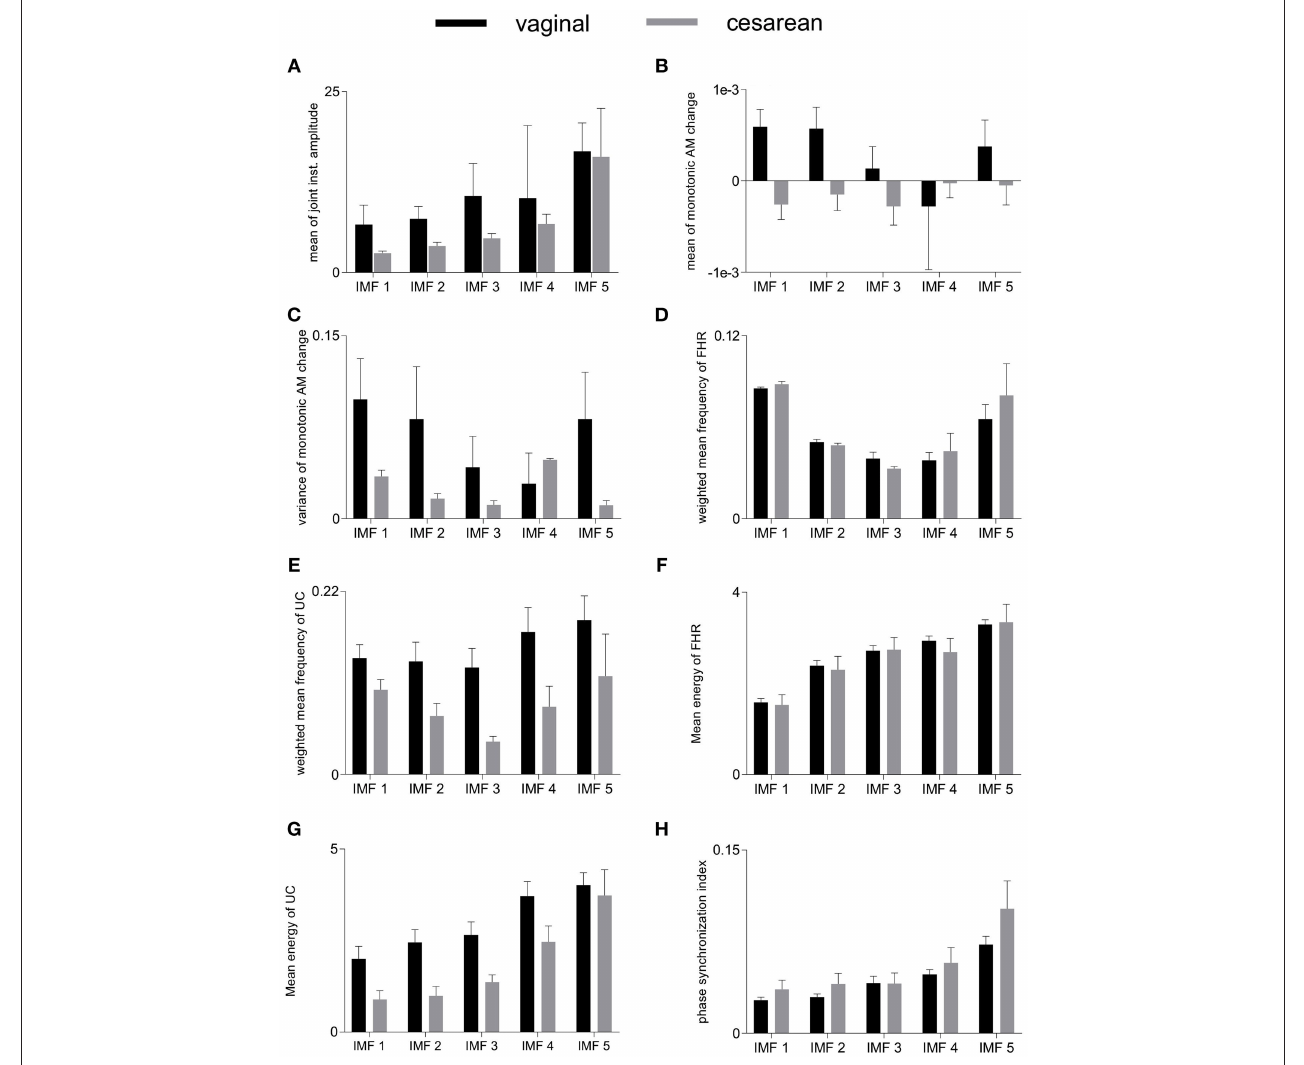
FIGURE 4 | Averaged values of individual features for vaginal and cesarean groups. Error bars represent standard errors. FHR, fetal heart rate; UC, uterine contraction; IMF, intrinsic mode function; AM, amplitude modulation. (A) mean of joint instantaneous amplitude, (B) mean of monotonic AM change, (C) variance of monotonic AM change, (D) weighted mean frequency of FHR, (E) weighted mean frequency of UC, (F) mean energy of FHR, (G) mean energy of UC, (H) phase synchronization